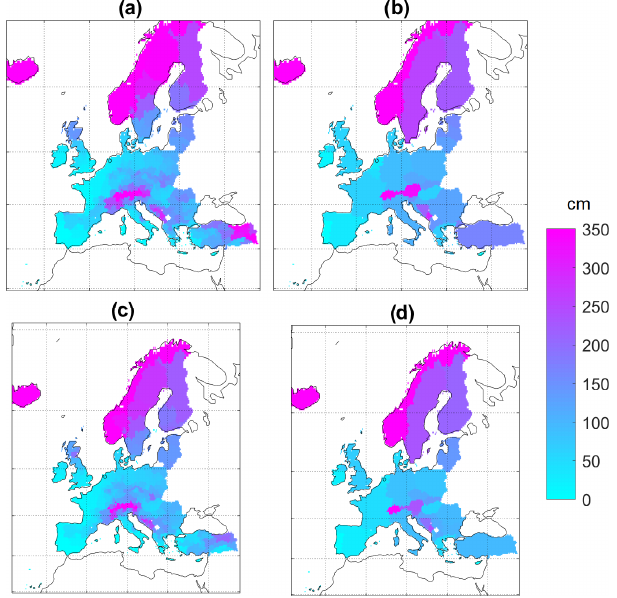
Figure 3. Differences in yearly total snowfall (SF) for two periods (average 1979–1998 subtracted from average 1999–2018) for the ERA5 (a, b) and E-OBSv20.0e (c, d) datasets. (a, c) NUTS-0 level, (b, d) NUTS-2 level. Significant differences are shown in shaded green (two-sided T test, 5% confidence